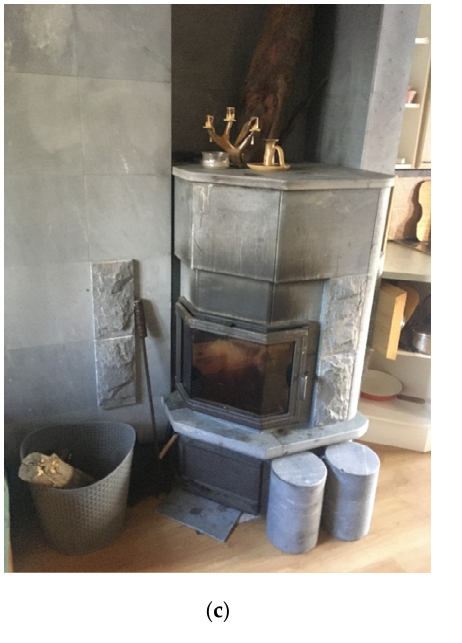
Figure 2. A cottage from the town of Ikaalinen, Finland: ( a ) entrance; ( b ) open kitchenette; ( c ) fireplace; ( d ) exterior view (Photos courtesy of Jenni Vilkman).